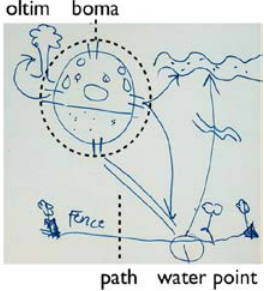
Figure 1. Maasai sketch communicating land